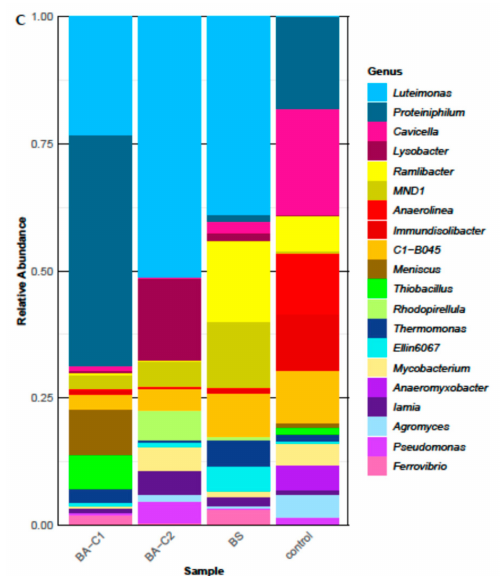
Figure 3. Soil bacterial community structure at the ( A ) class and ( B ) family level after 60-day bioremediation treatments. ( C ) Twenty of the most abundant genera in the analyzed communities. Please note that the sum of the relative abundances (100%) shown here refers only to the most abundant genera for better visualization of the results. The real values are presented in Section 2.4. Control: untreated microcosms, BS: biostimulated microcosms, BA-C1 and BA-C2: microcosms bioaugmented with the community C1 and the mixed culture C2,